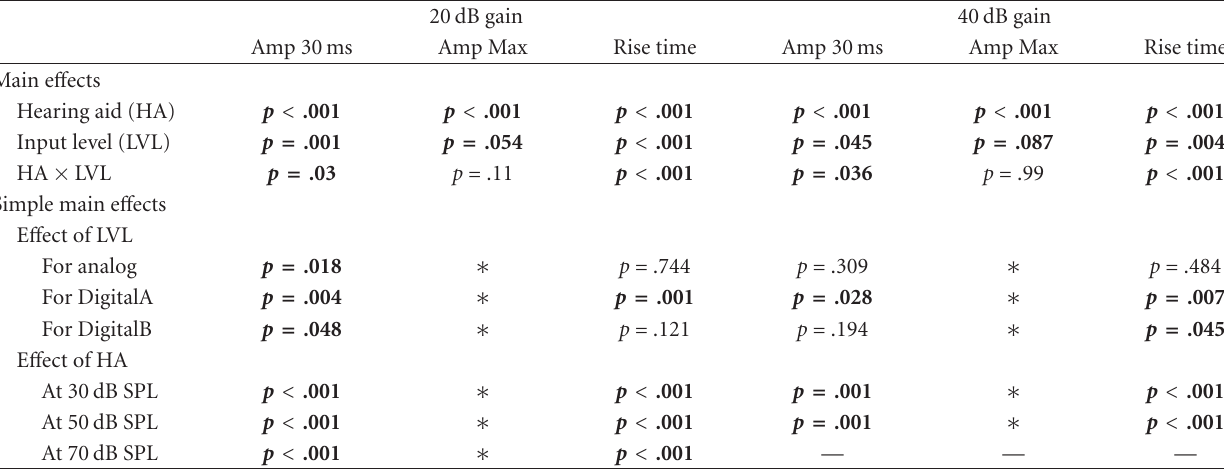
Table 3: ANOVA results for all measures of the short stimulus. Shown are p values of the ANOVA and of the simple main e ff ects, where appropriate.